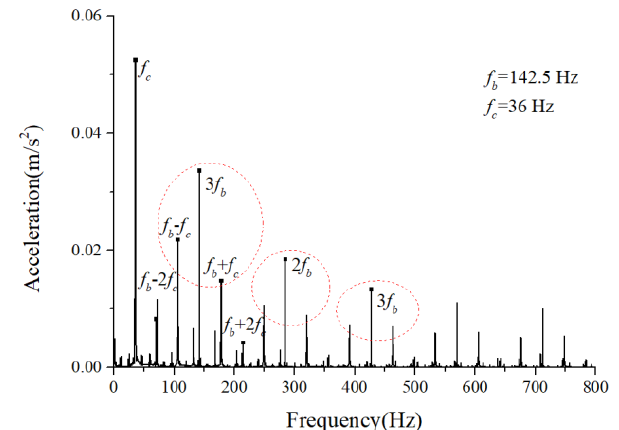
Figure 27. Acceleration waveform.